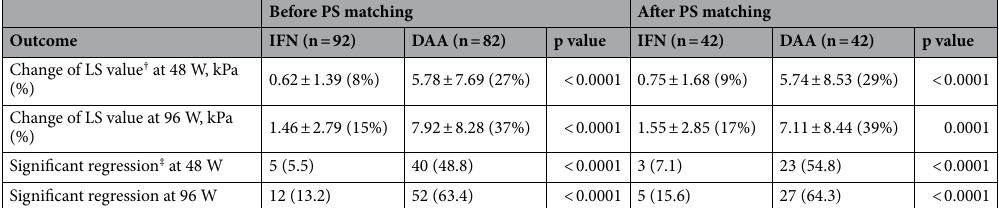
Table 3. Changes in liver stiffness before and after propensity score matching (PS1). † Changes of LS value are described as subtracted change from baseline LS (percentage change). ‡ Significant regression was defined as more than 30% reduction of liver stiffness from baseline. PS, propensity matching; IFN, interferon; DAA, direct antiviral agents; LS, liver stiffness; W, week.